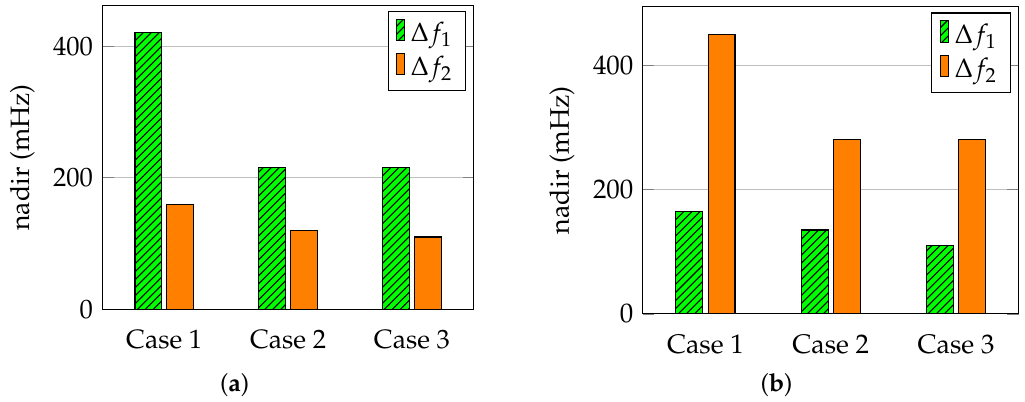
Figure 10. Nadir: Comparison of ∆ P L ,1 and ∆ P L ,2 scenarios. ( a ) Area 1 submitted to imbalance ( ∆ P L ,1 ); ( b ) Area 2 submitted to imbalance ( ∆ P L ,2